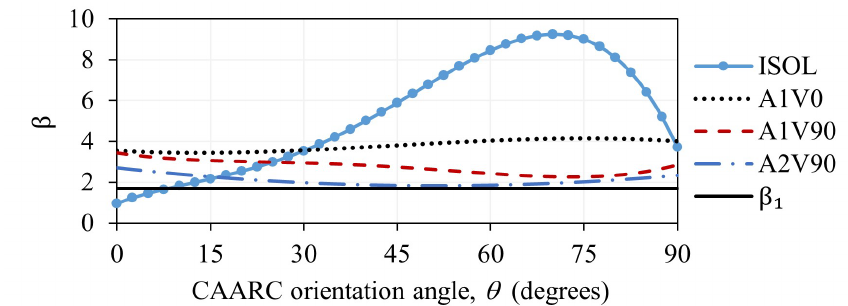
Figure 10. Reliability index β for displacement, x-direction – limit criterion of